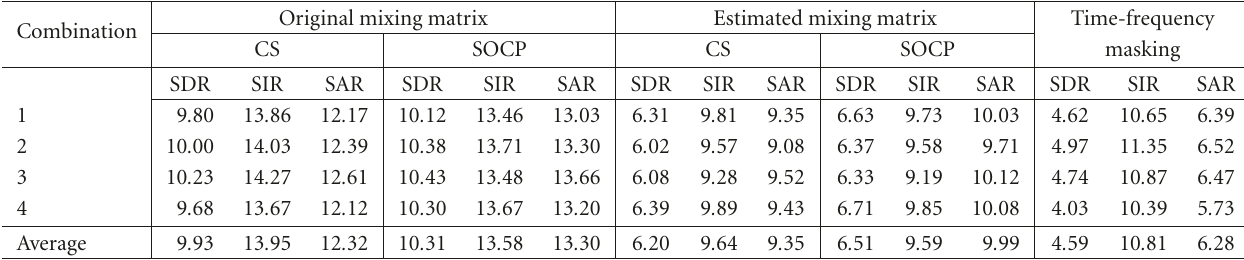
Table 5: Separation results for 5 sources (1, 2, 3, 4, 6), 3 mixtures (1, 2, 3).